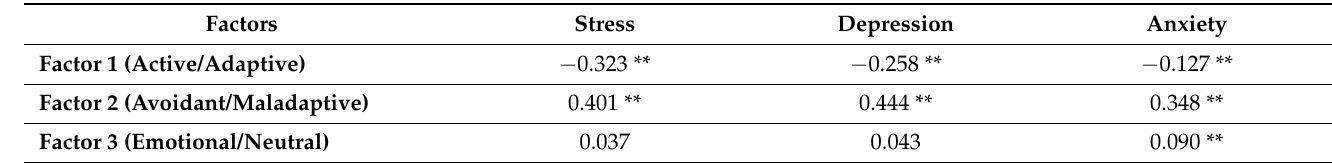
Table 3. Bivariate correlations between each factor and stress, depression, and anxiety (convergent and divergent